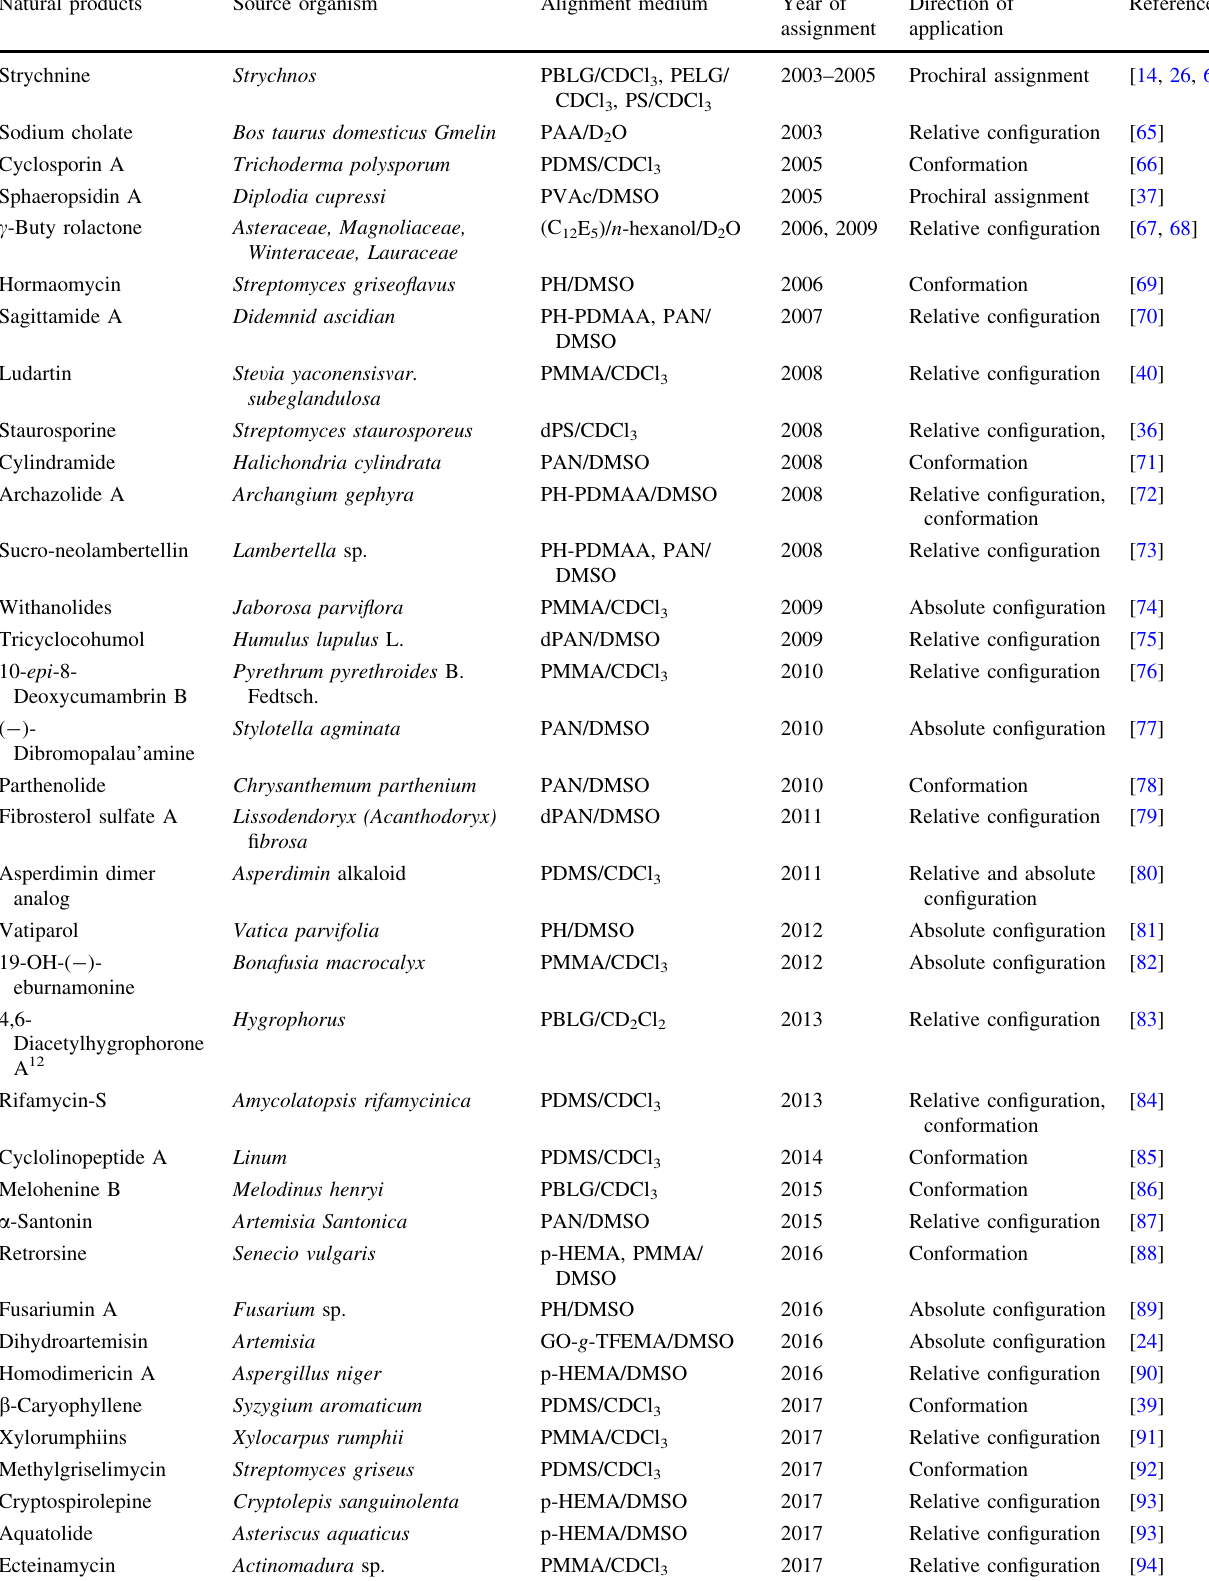
Table 3 Natural products stereochemistry applications of RDCs Natural